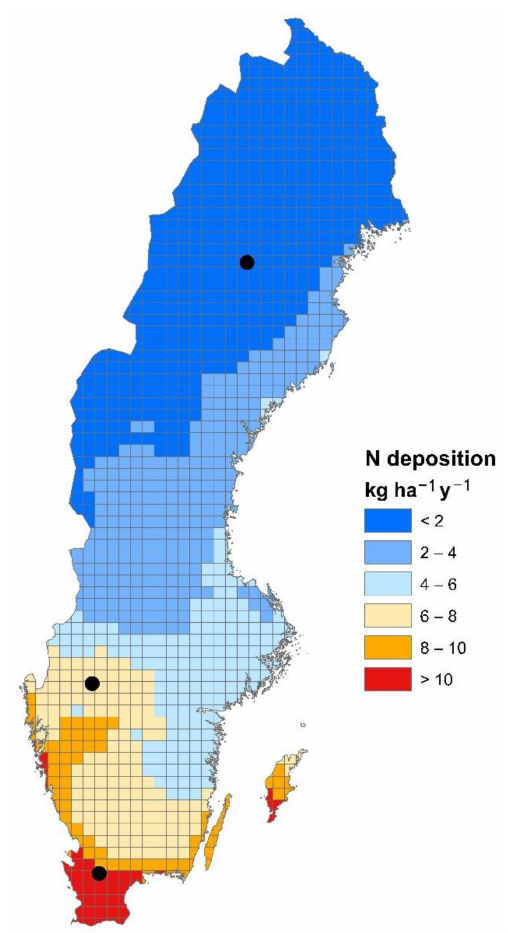
Figure 1. Total deposition of inorganic N (NO 3 -N + NH 4 -N) to spruce forest 2017, according to the MATCH model [37]. The black dots are the three modeling sites: Högbränna in Northern Sweden, Södra Averstad in Central Sweden and Västra Torup in Southern